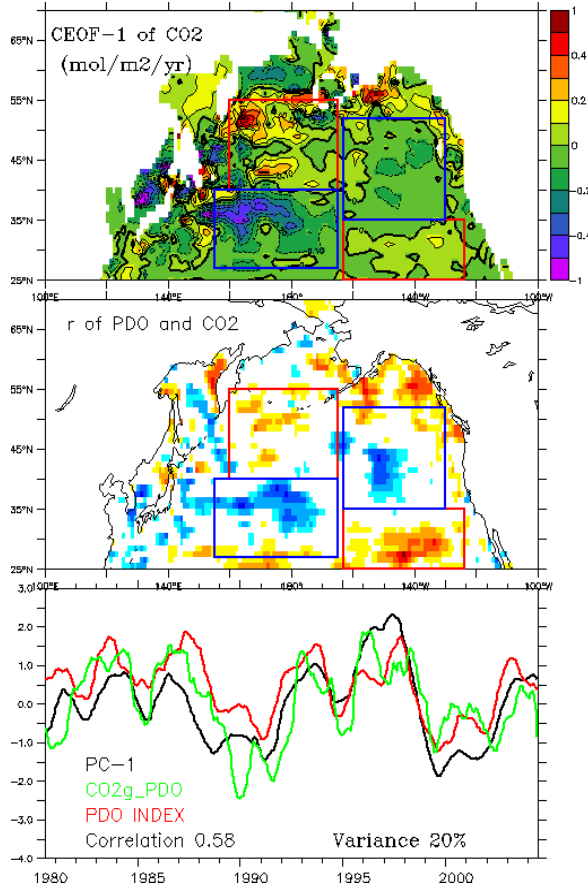
Fig. 12. (top) Spatial pattern of CO 2 flux from CEOF of CO 2 flux Figure 12: (top) Spatial pattern of CO2 flux from CEOF of CO 2 flux with SST and SSH. (middle) Same 3 with SST and SSH. (middle) Same as top-left panel of Fig. 4. (bot- as top-left panel of Figure 4. (bottom) PC-1, CO 2 g_PDO and PDO index (see Figure 4 caption for more 4 tom) PC-1, CO 2 g PDO and PDO index (see Fig. 4 caption for more details). The correlation (0.58) shown is between PC-1 and PDO index. 5 details). The correlation (0.58) shown is between PC-1 and PDO 6